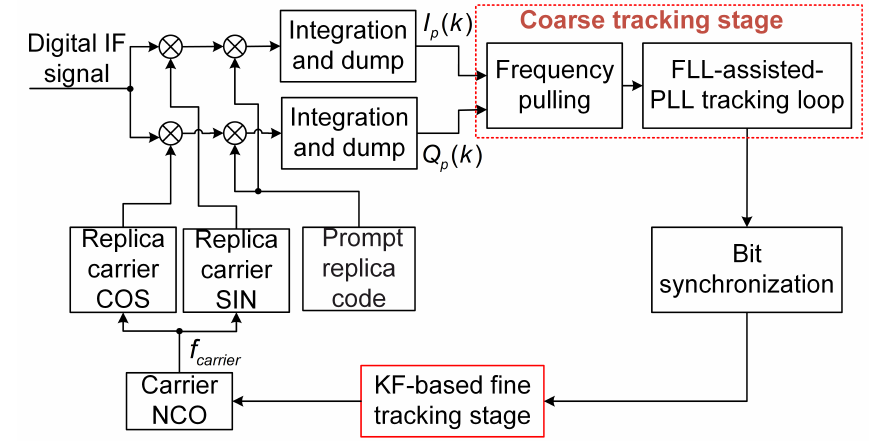
Figure 4. Block diagram of the KF-based coarse-to-fine carrier tracking strategy. (KF: Kalman